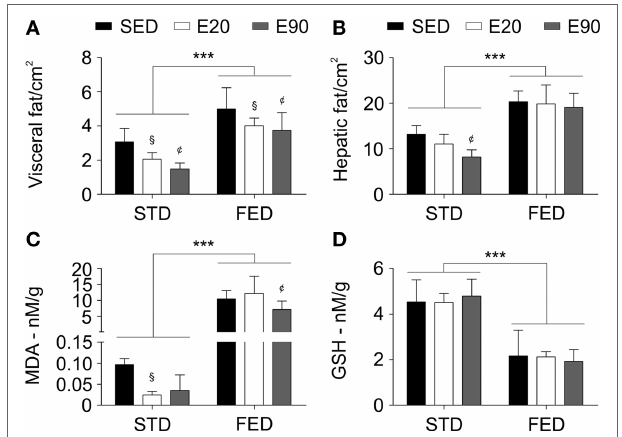
FigUre 6 | a physical training does not recover the hepatic tissue damage induced by a fat-enriched diet . Computerized tomography analyzed the fat tissue density in visceral ( a) and liver areas (B) . Standard biochemical analyses determined malondialdehyde [MDA; (c) ] and reduced glutathione [GSH; (D) ] levels in liver samples. Statistical Analysis I: ¢ p < 0.05 vs standard diet (STD)-SED or FED-SED; § p < 0.05 vs STD-SED or FED-SED. Statistical Analysis II: *** p < 0.001. Data analysis: two-way ANOVA test (Bonferroni’s post hoc test). Reported values are the mean ±